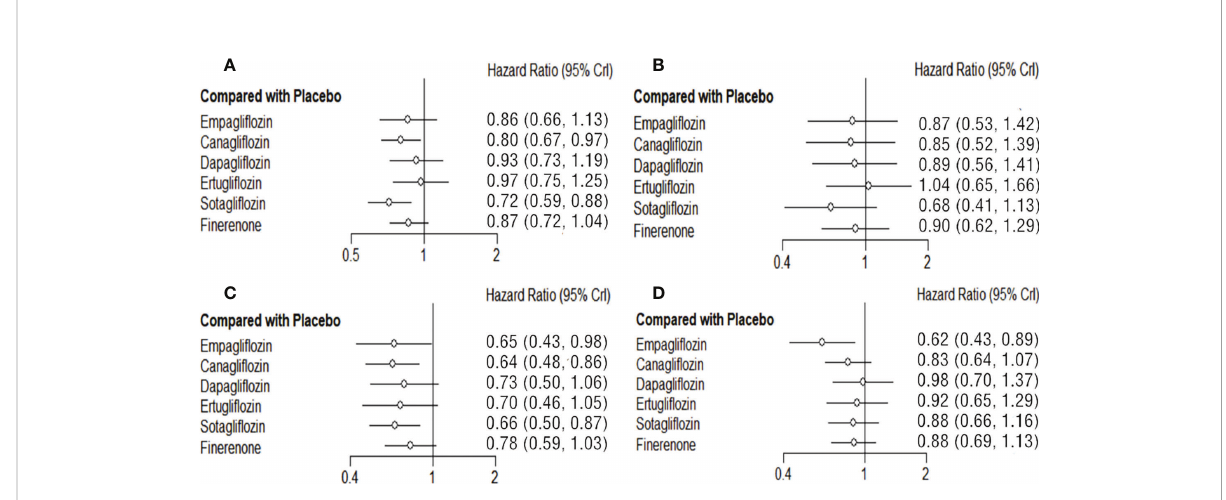
FIGURE 3 Comparison between the ef fi cacy of SGLT2i and fi nerenone and placebo on MACE (A) , MI (B) , HHF (C) and CVD (D)